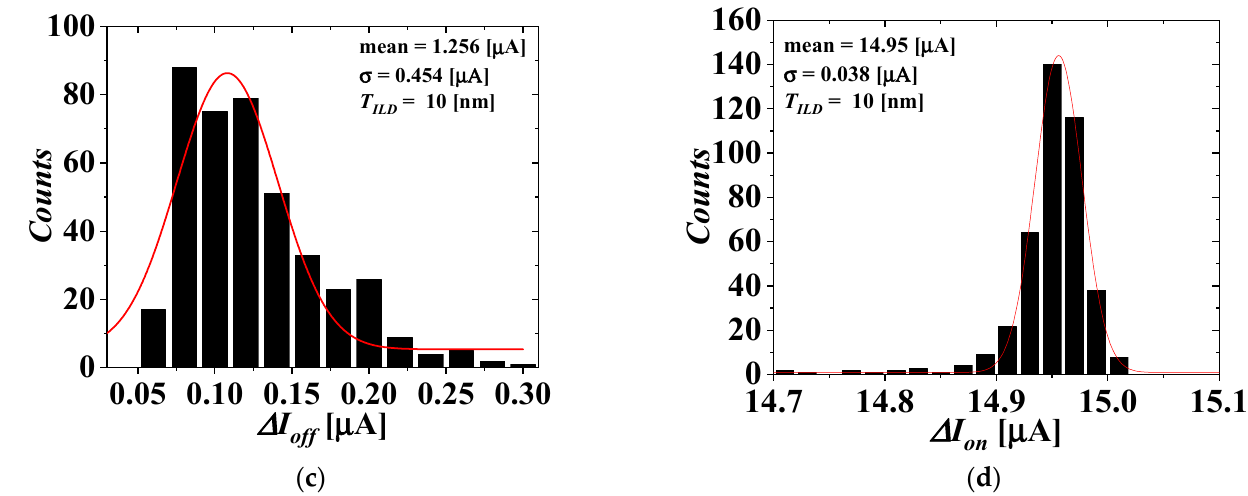
agreement with the simulated ones (red, empty triangles) within a 10% error. The means Figure 7. The distributions of the electrical parameter changes by V BG between 0 and 1 V of the top- and the measured and calculated standard deviations, shown in Figure 10, are summa- Figure 7. The distributions of the electrical parameter changes by V BG between 0 and 1 V of the tier NMOS considering the WFV effects of both the top- and bottom-tier gates. ( a ) Δ V th , ( b ) Δ SS, ( c ) rized in Table 2. top-tier NMOS considering the WFV effects of both the top- and bottom-tier gates. ( a ) ∆ V th , ( b ) ∆ SS, Δ I Δ I off , and ( d ) on . ( c ) ∆ I off , and ( d ) ∆ I on . For the three cases where the WFV effect on the top-tier NMOS gate only, the bottom- tier PMOS gate only, and both the top- and bottom-tier NMOS/PMOS gates were consid-